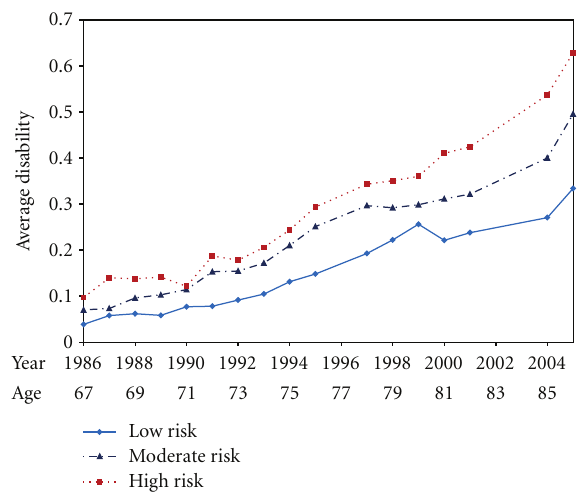
Figure 2: Average disability scores by age and calendar year, Uni- versity of Pennsylvania Study 1986–2005.